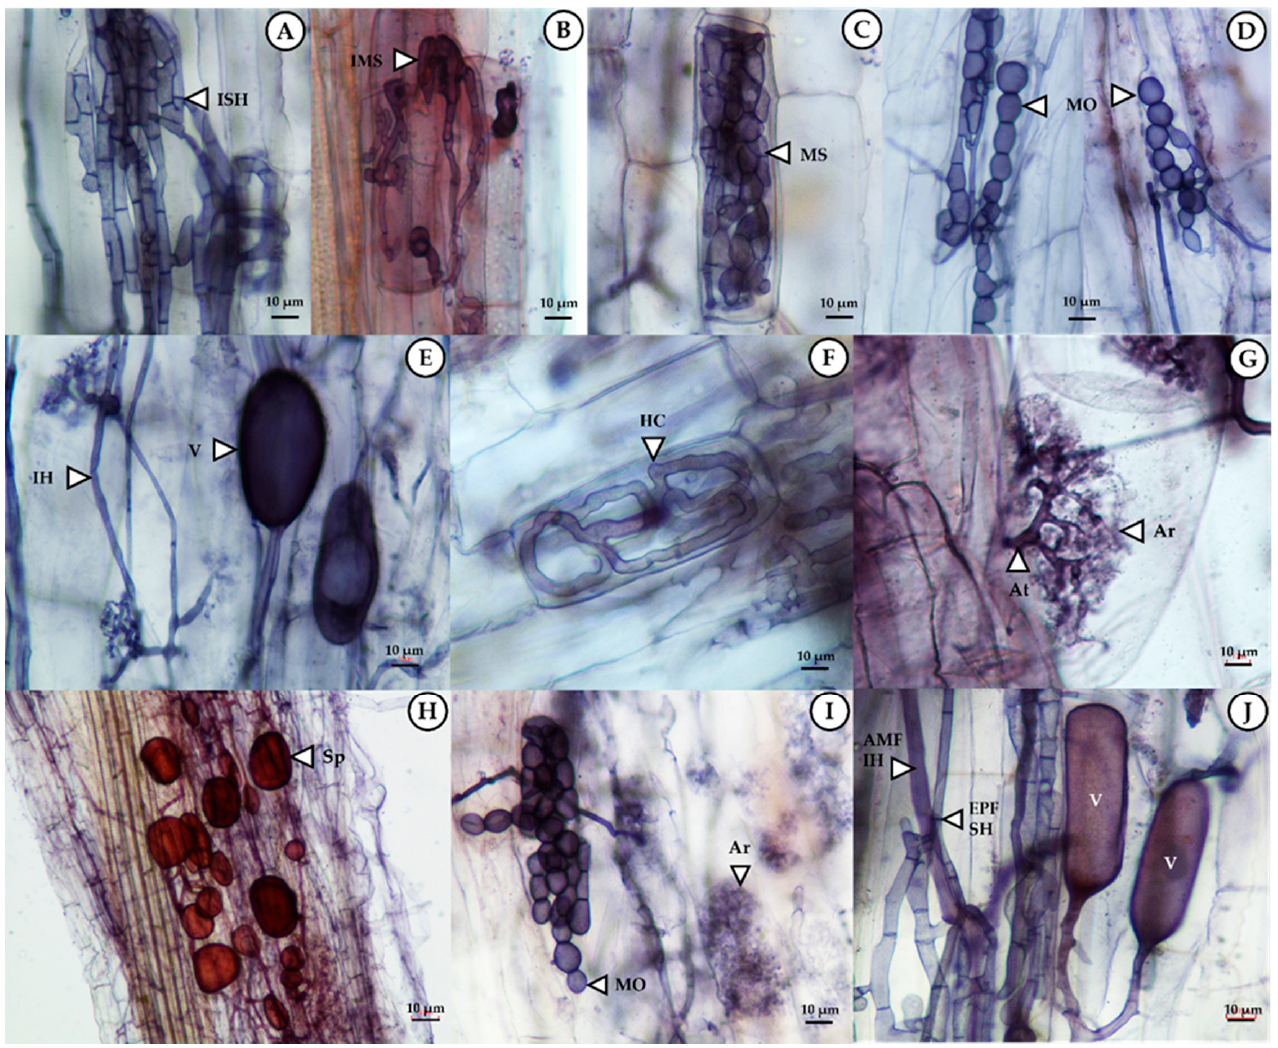
Figure 1. Colonization structures of endophytic fungi: EPF ( A – D ), arbuscular mycorrhizal fungi: AMF ( E – H ), and co-inoculation with EPF and AMF ( I – J ) in the roots of sunchoke observable in EPF-inoculated plants treatment (T4), AMF-inoculated plant treatment (T5), and co-inoculation of EPF and AMF-treated plant treatment (T6), respectively. ( A ) Intracellular septate hyphal: ISH, ( B ) Initiation, development, and formation of microsclerotia: IMS, ( C ) Microsclerotia: MS, ( D ) Moniliform cell: MO, ( E ) Intracellular hyphal: IH and Vesicles: V, ( F ) Hyphal coil: HC, ( G ) Arbuscule trunks: At and Arbuscules: Ar, ( H ) AMF spores: Sp, ( I ) Moniliform cell of endophytic fungi: MO, Arbuscules of AMF: Ar, and ( J ) AMF intracellular hyphal: AMF IH, AMF Vesicles: V, and Intracellular septate hyphal of endophytic fungi: EPF SH. Scale bars are 10 µ